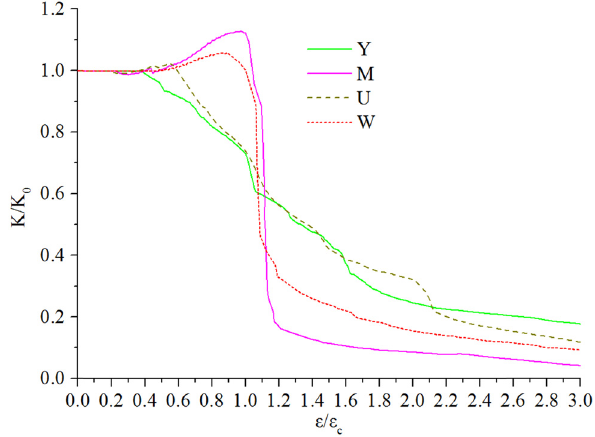
Figure 18: Sti ff ness degradation curves of EPS